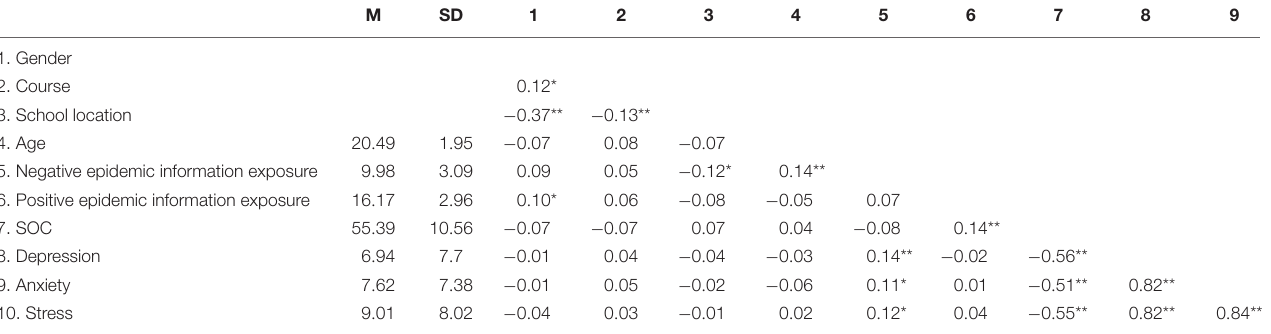
TABLE 1 | Descriptive statistics and correlations among study variables ( N = 424).